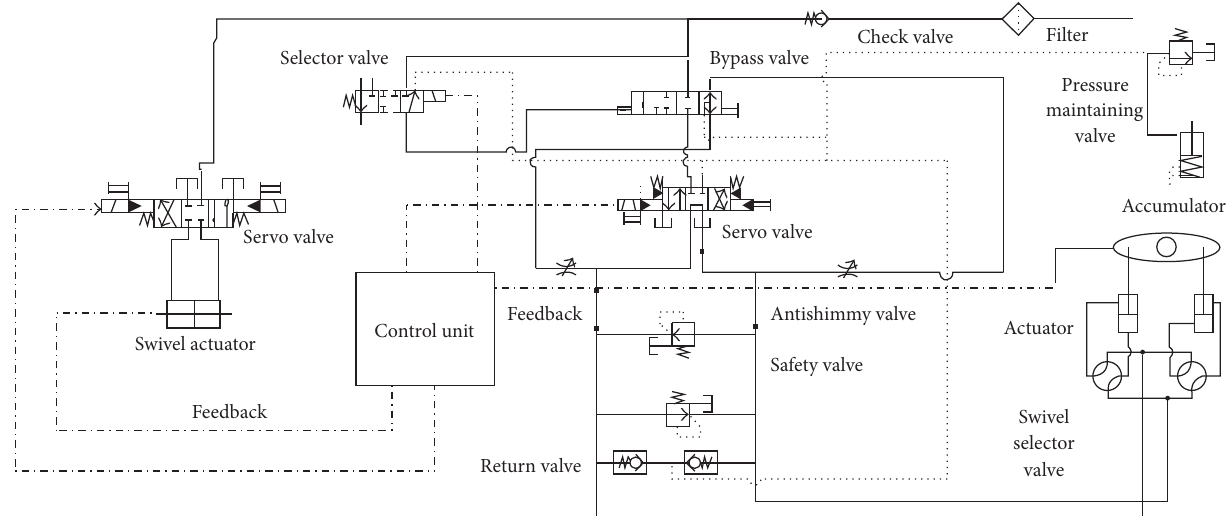
Figure 21: Schematic diagram of ground test system.